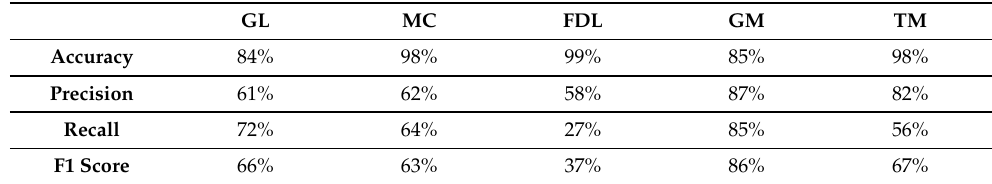
Table 12. Performance metrics for final faster R-CNN ResNet101 model on the test set, using a score threshold of 0.05 and 0.1 NMS